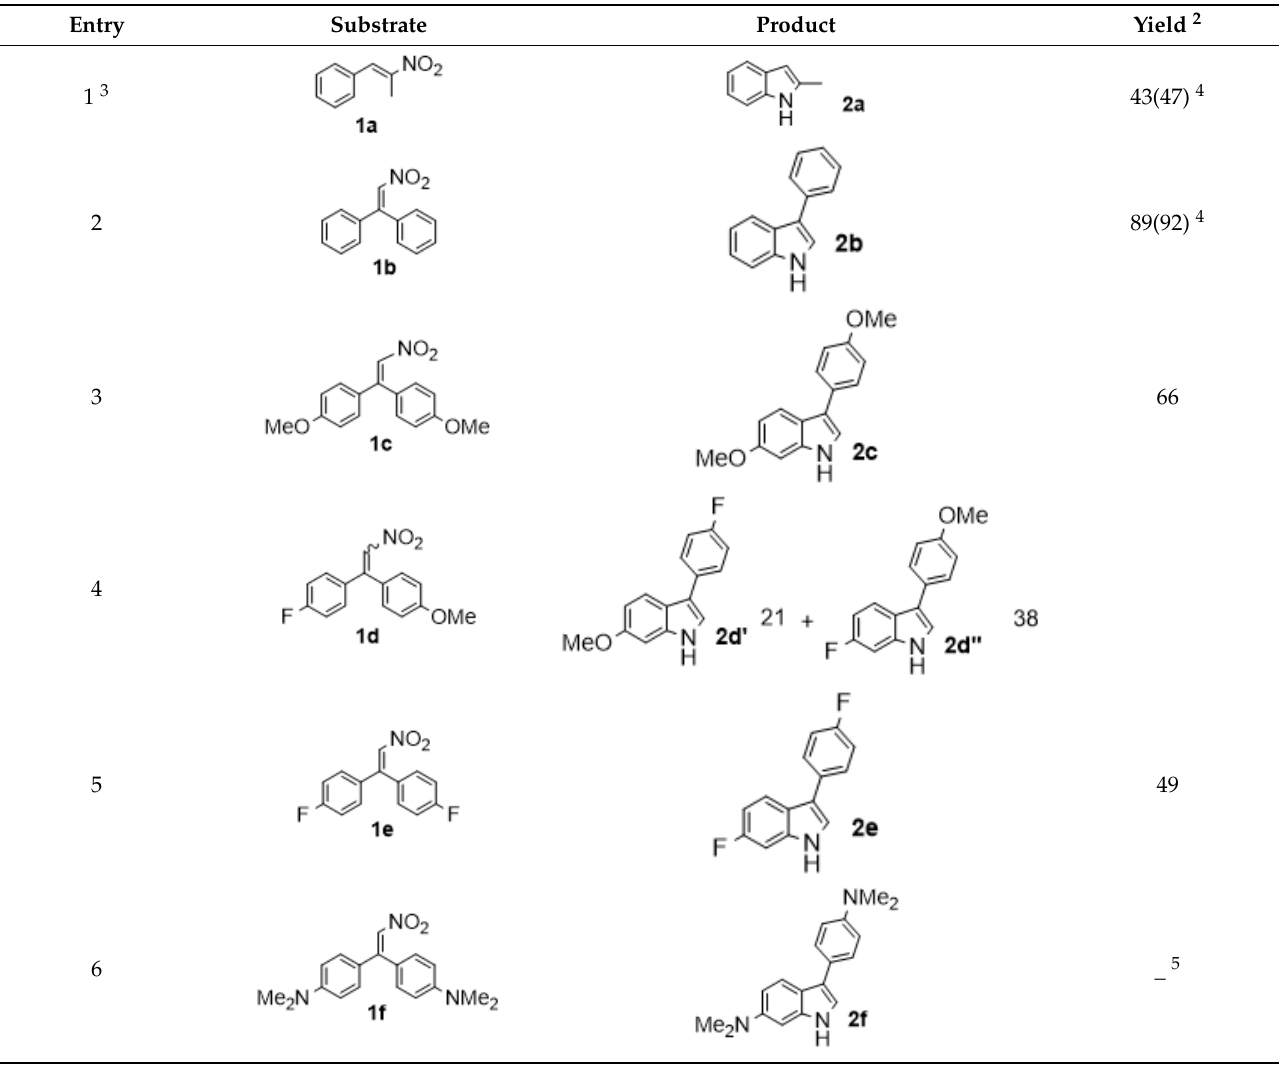
Table 3. Substrate scope 1 .